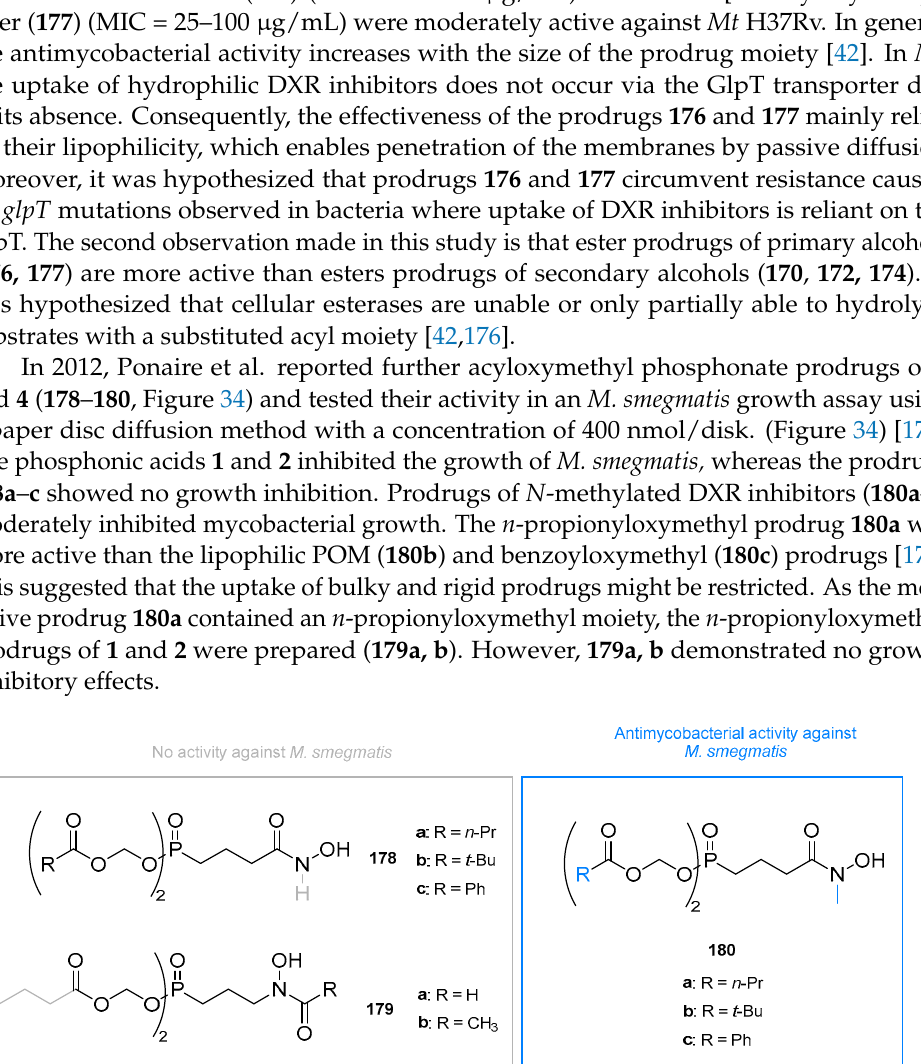
Figure 34. Antimycobacterial activity of prodrugs ( 178 – 180 ) against M. smegmatis determined by paper disc diffusion method.